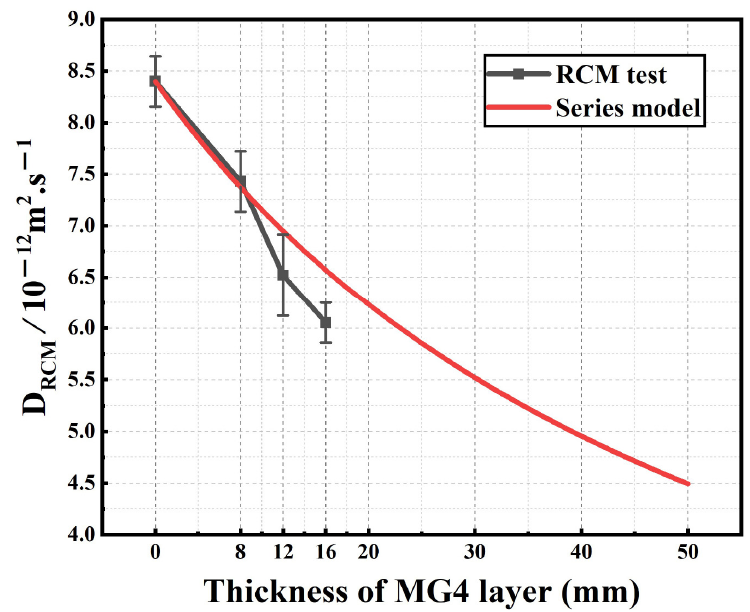
Figure 13. Measured and predicted chloride migration coefficient of layered samples.